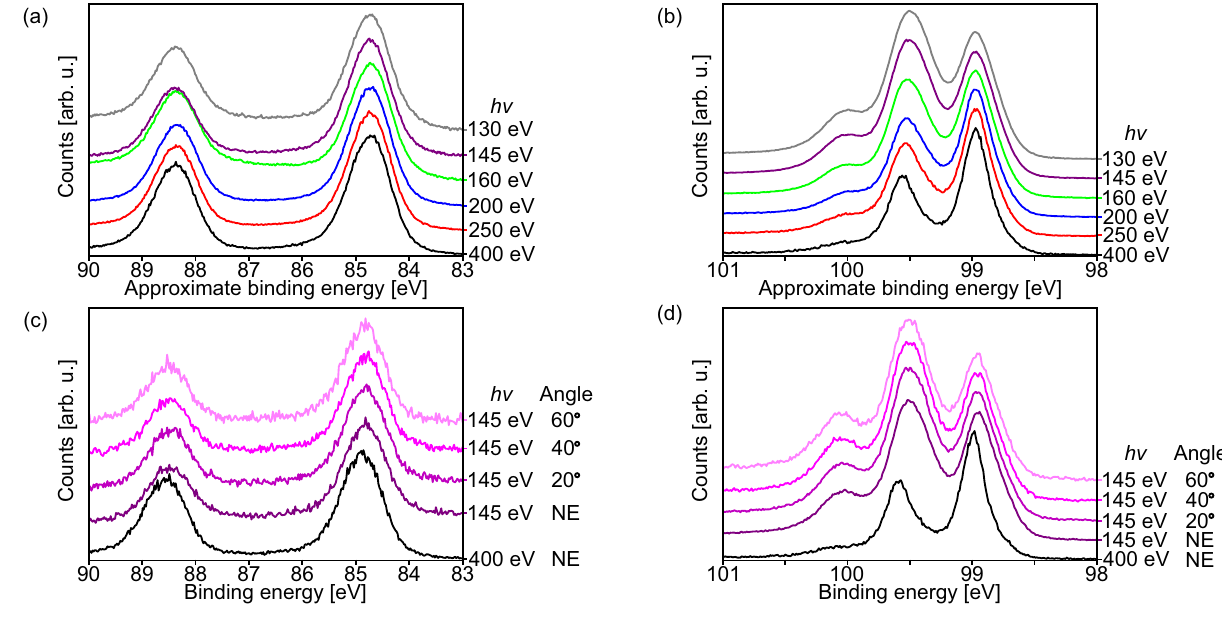
Figure 5. ( a ) Au 4f and ( b ) Si 2p spectra of an Au silicide nanowires sample at varying photon energies in normal emission (NE). ( c ) Au 4f and ( d ) Si 2p spectra of another Au silicide nanowires sample at varying photon energies and emission angles. Both samples were prepared by depositing about 1.0 ML of Au at room temperature and annealing at 600 ◦ C . A constant background was subtracted from all spectra, which were then normalized to show the same height for the first distinguishable peak at lowest binding energy. The binding energy scales in ( c ) and ( d ) were calibrated by determination of the Fermi level, which was not possible for ( a ) and ( b ) due to charging